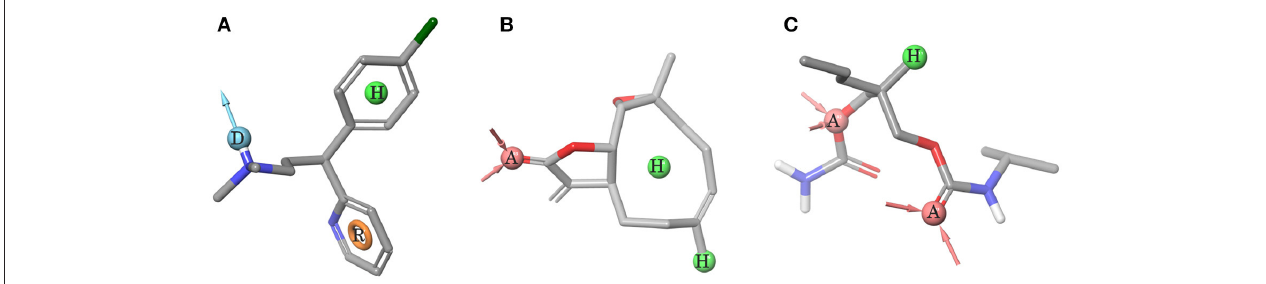
FIGURE 4 | Pharmacophore models. (A) ggTas2r1 pharmacophore DHR ( = H-Bond donor, hydrophobic feature, aromatic ring), reference structure chlorpheniramine, Sensitivity = 0.86, Specificity = 0.75. (B) ggTas2r2 pharmacophore AHH ( = H-bond acceptor, hydrophobic feature, hydrophobic feature), reference structure quinine, Sensitivity = 0.67, Specificity = 0.62. (C) ggTas2r7 pharmacophore AAH ( = H-bond acceptor, H-bond acceptor, hydrophobic feature), reference structure carisoprodol, Sensitivity = 0.78, Specificity = 0.68. Acceptor (red) and donor (cyan) features are shown as spheres and vectors, hydrophobic feature as green sphere, and aromatic feature as orange ring.